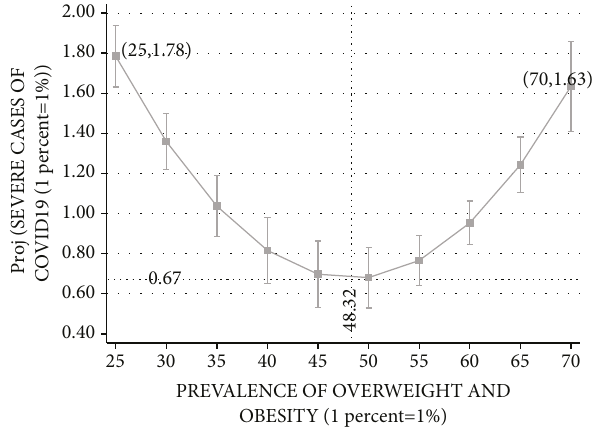
Figure 6: COVID-19 as the cause of death vs. prevalence of overweight and obesity. The vertical axis measures the projected probability of SARS-COV-2 virus as the cause of death rather than other reasons. The horizontal axis measures the prevalence of overweight and obesity (BMI ≥ 25, where BMI � kg/meter 2 ) in the population of OECD countries based on measured height and weight. The figure is based on the following regression outcomes given in column (1).